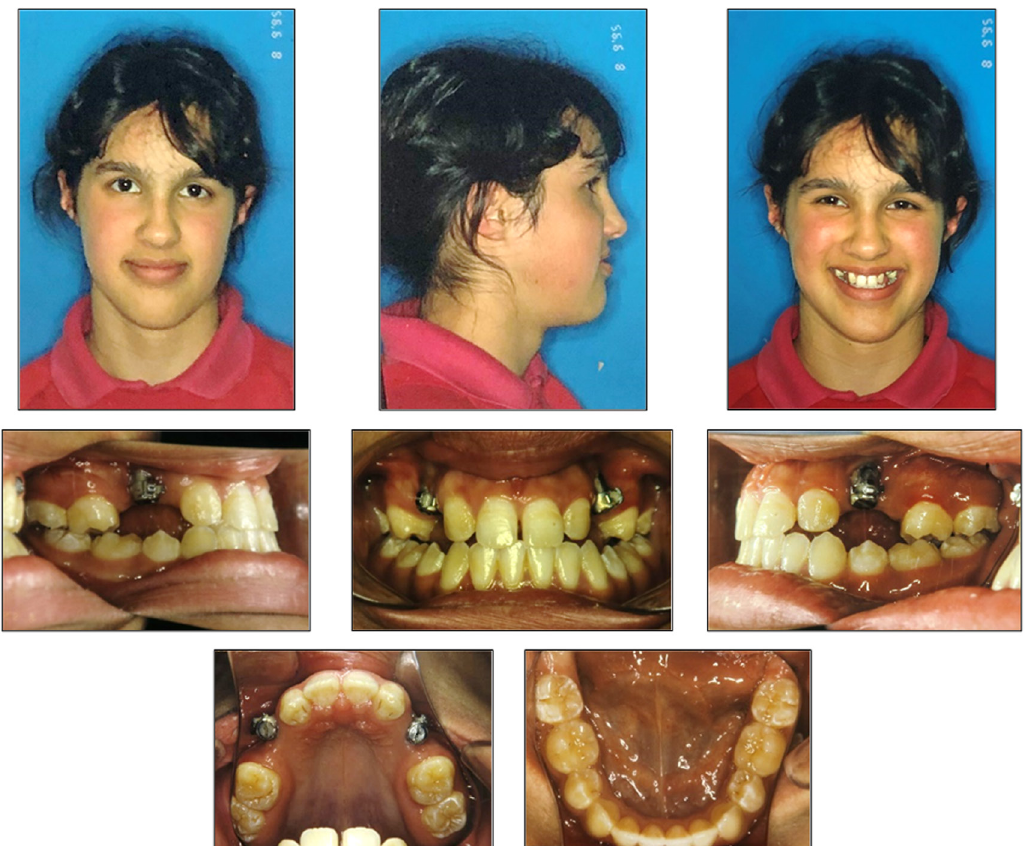
Figure 5. Completion of full fixed appliances photographs